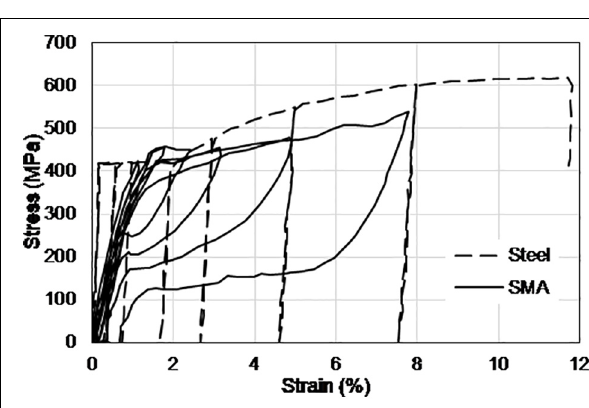
FIGURE 5 | Cyclic stress-strain response of steel and SMA rebar.